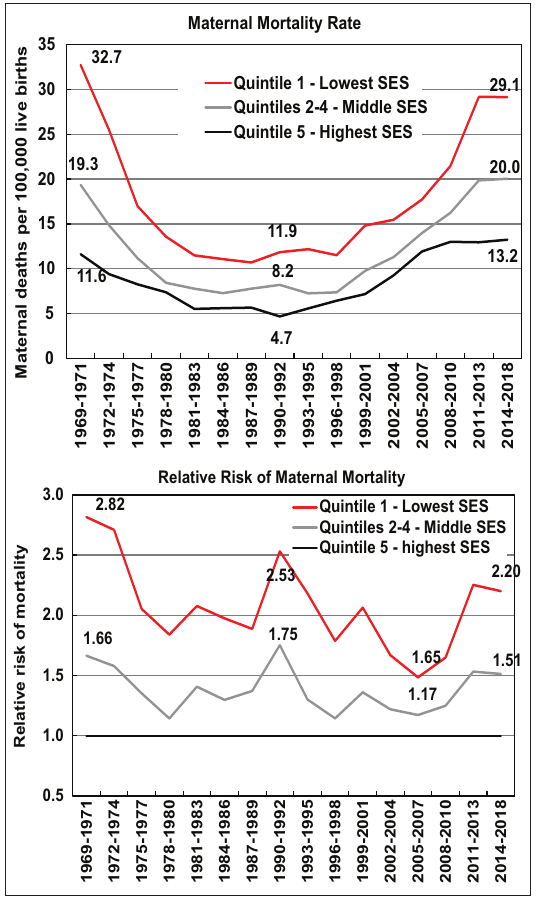
Figure 3 : Maternal Mortality Rates and Risks by Area Depriva - tion, United States, 1969-2018 . Source: Data derived from the National Vital Statistics System linked to county-based area deprivation